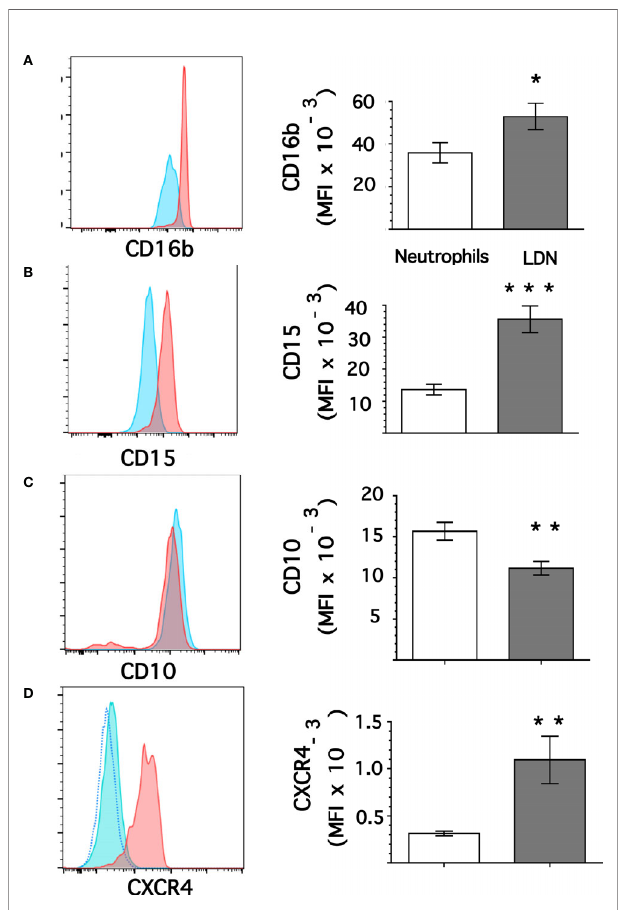
FIGURE 4 | Low-density neutrophils display higher expression of CD15 and CD16b. Leukocytes in blood from young healthy donors were separated by density gradient centrifugation. Then, neutrophils (blue) or LDN (red) were analyzed by fl ow cytometry for membrane expression of CD16b (A) , CD15 (B) , CD10 (C) , CXCR4 (D) . Left panels are representative histograms of 11 experiments panel (A) or of 3 experiments panels (B – D) with similar results. The dotted line in panel (D) is for unlabeled (negative) cells. Right panels show the Mean ± SEM of the mean fl uorescence intensity (MFI) for each molecule. Asterisks denote statistical differences between LDN and neutrophils (*p = 0.044, **p = 0.01, ***p = 0.001).